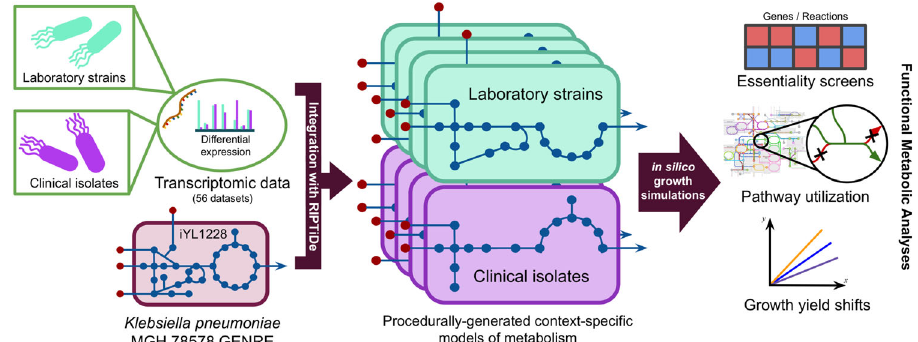
Fig. 2 General procedure for generating context-speci fi c models of metabolism from transcriptomic data. All 56 datasets from the transcriptome meta-analysis were used to generate distinct context-speci fi c models of K. pneumoniae metabolism.